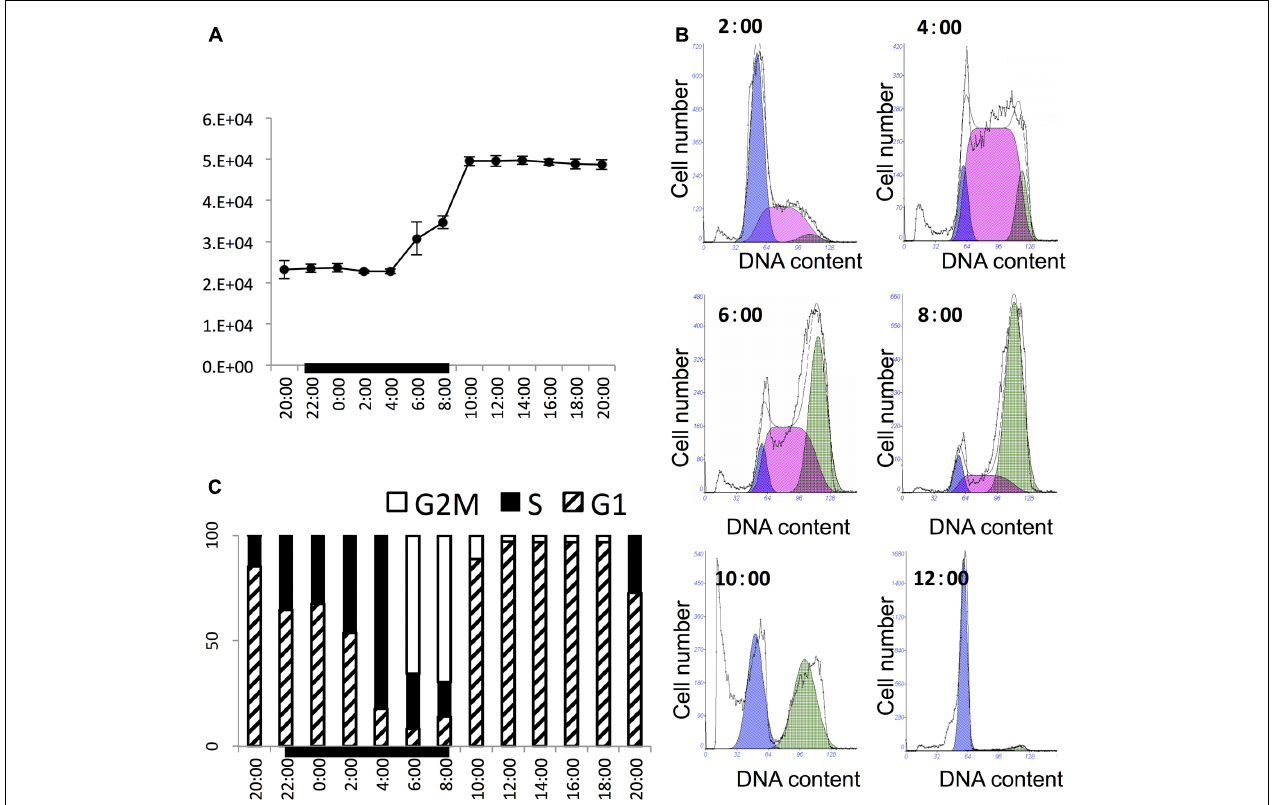
FIGURE 1 | Cell growth pattern and cell cycle of P. donghaiense in the diel cycle. (A) Diel growth pattern of P. donghaiense in the synchronized culture. (B) Flow cytometric profile of key time points of cell division. The colored area indicate fitted cell cycle phase, purple appears to be for G1, pink for S and green for G2M phase. (C) Diel cell cycle profiles of P. donghaiense in the sampling period. The bar graph was derived from the flow cytometric DNA content.